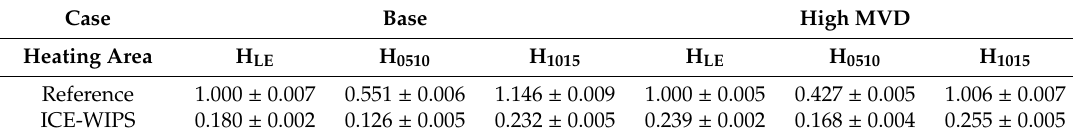
Figure 9. Normalized power consumption per unit area of each heating area for High MVD case. Table 2. Summary of normalized power consumption per unit area in validation test.